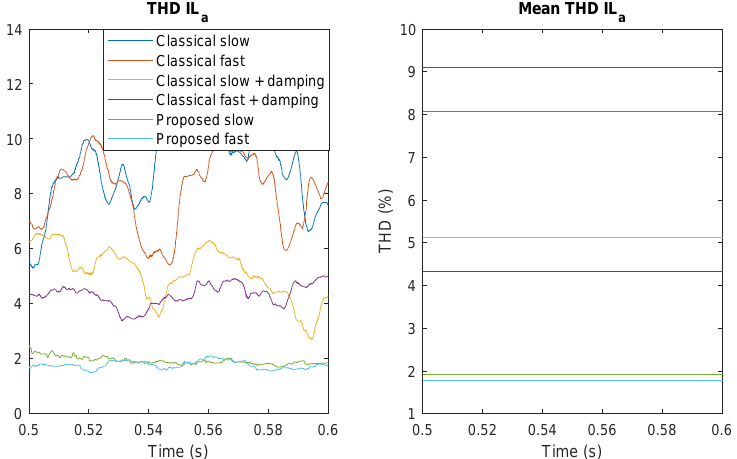
Figure 13. Simulation results: THD (%) of the grid current (phase a) in the different cases. Grid voltage is at 110 V with a 10 Ω resistive load. Parameters are listed in Tables 3 and